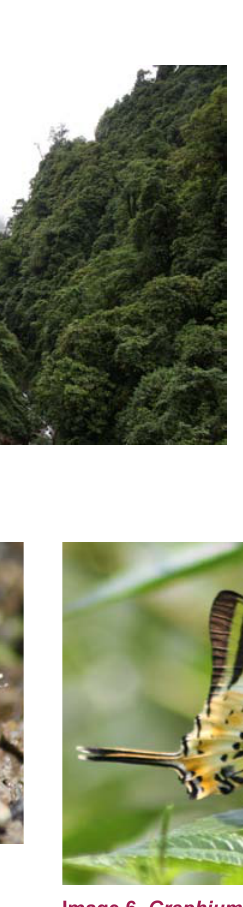
Image 6. Graphium antiphates pompilius